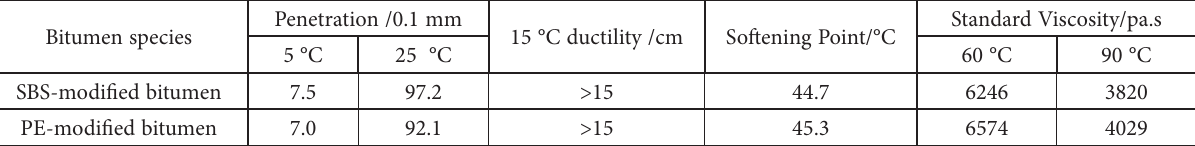
Table 1. Technical limits of SBS- and PE-modified bitumen Penetration /0.1 mm Bitumen species SBS-modified